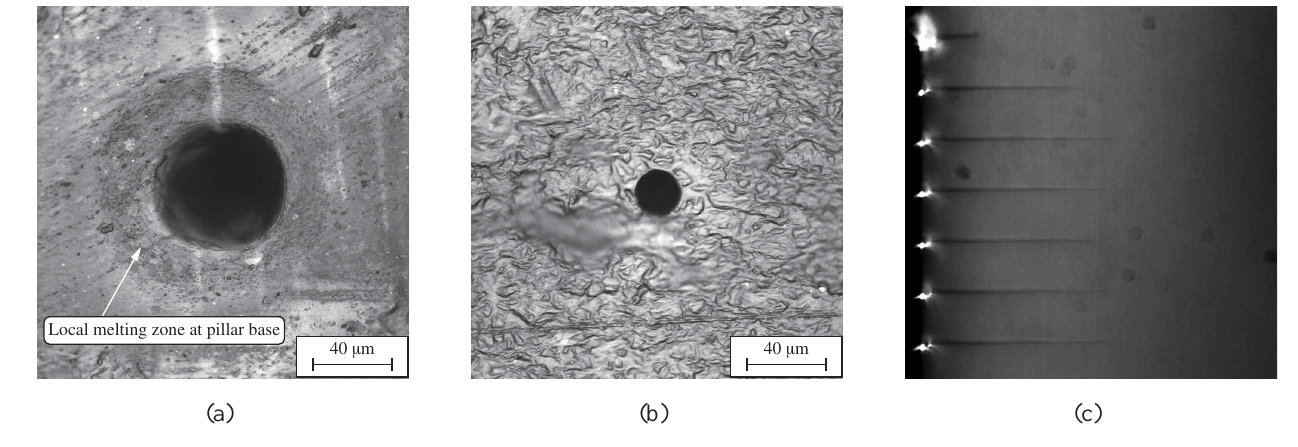
Figure 3. View of perforations into a wax foil at the entry and exit side of the laser beam. The entry diameter of the perforation is D = 38 m m ( a ) and corresponding exit hole with D = 15 m m in ( b ), respectively. ( c ) Side view of the perforations in the wax. Tapped blind holes (laser from left) for different number of laser